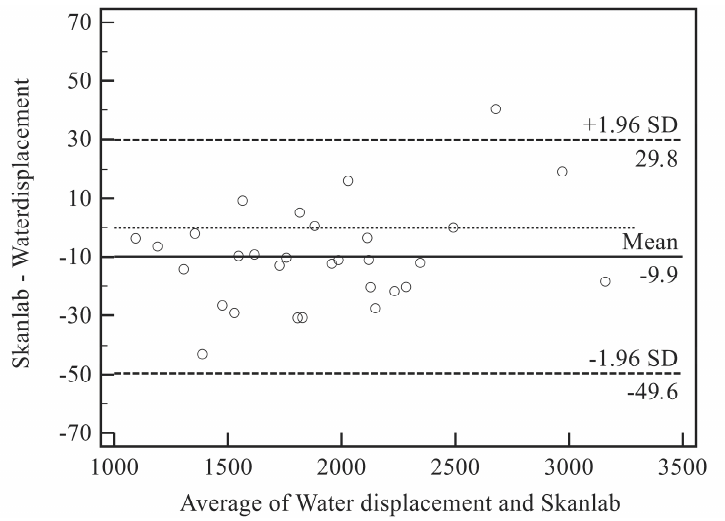
Figure 4. Bias and limits of agreement between SkanLab and Water displacement for human arms. SD, standard